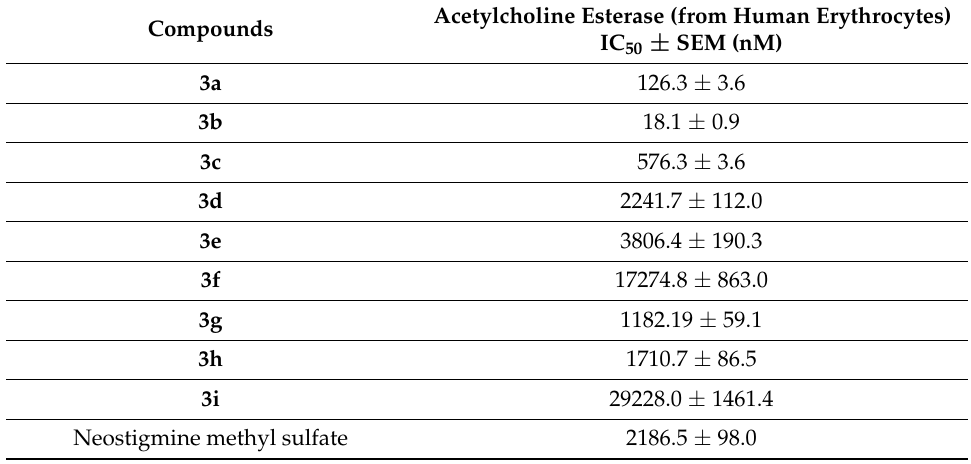
Table 1. Acetylcholine esterase inhibitory activity of derivatives ( 3a–3i